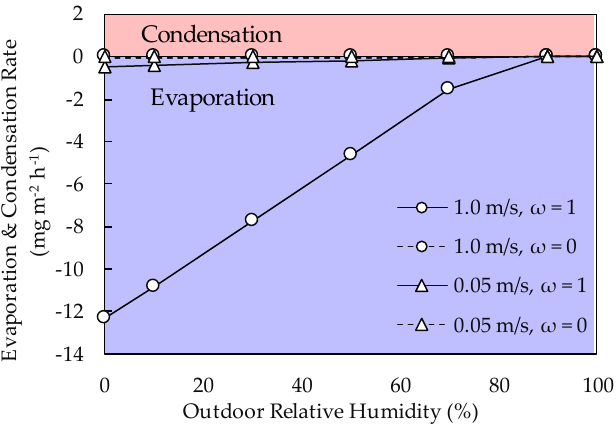
Figure 12. Evaporation and condensation effects relevant to the outdoor environmental conditions and RWS on the surface of the concrete on underfloor space.